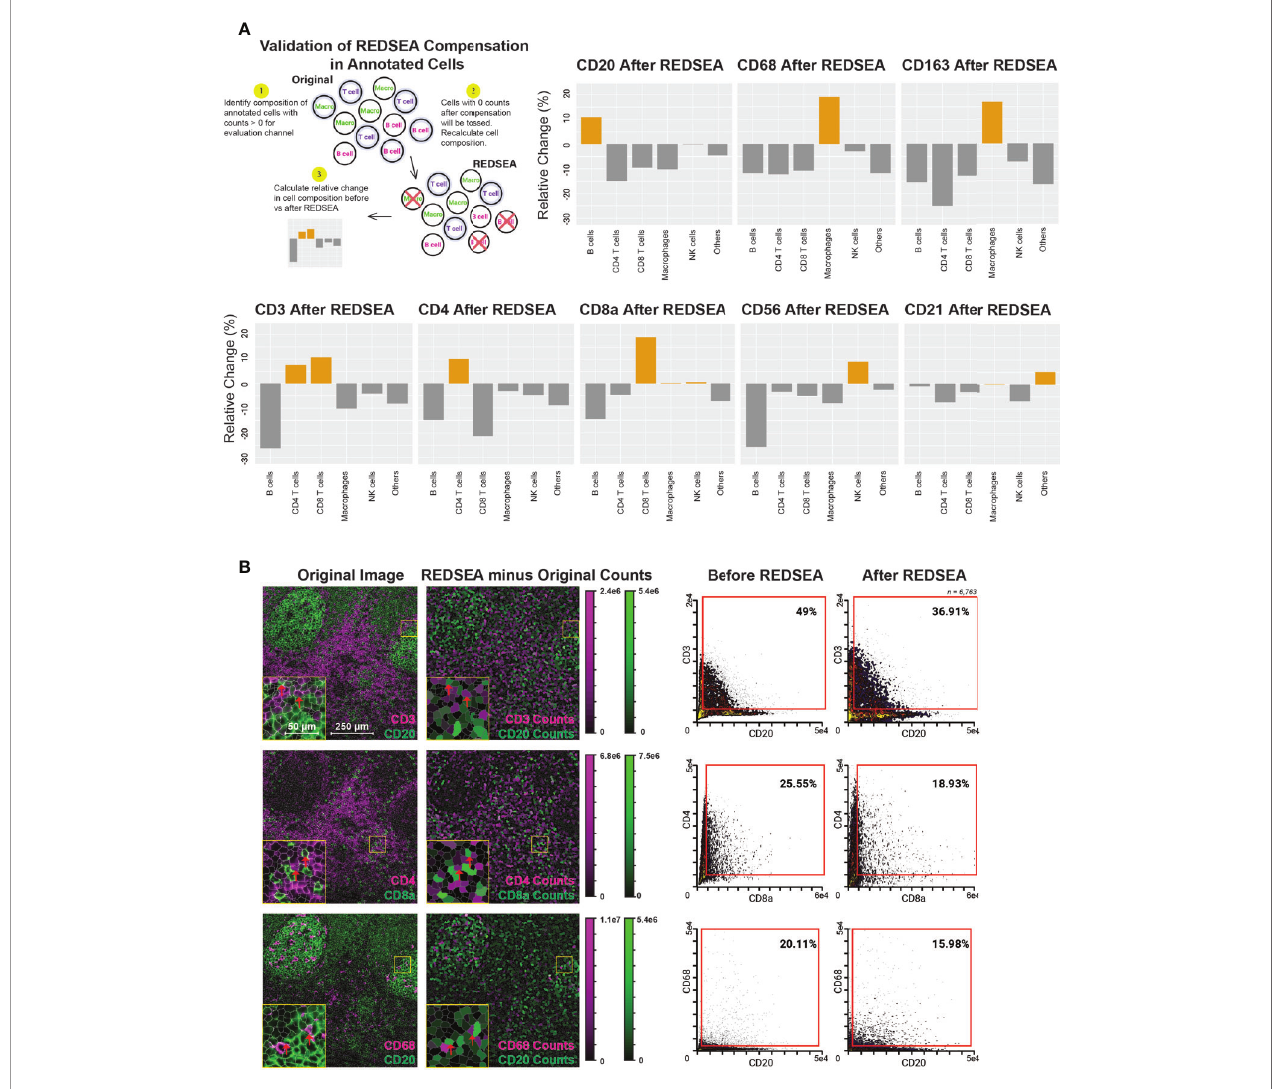
FIGURE 3 | REDSEA Enriches for Cell-type-speci fi c Signals and is Platform Agnostic. (A) Schematic of the work fl ow for calculation of enrichment and depletion of various cell types for each channel before and after REDSEA correction. Cells with no counts in the channel of interest after REDSEA correction were discarded, and the percentage composition of each cell type remaining was calculated. The relative change is the difference in percentage composition of each cell type before and after REDSEA correction. (B) Left: A representative 900 µm x 900 µm CyCIF image of a human tonsil. Three pairs of mutually exclusive markers are shown: CD3 (magenta) and CD20 (green); CD4 (magenta) and CD8a (green); and CD68 (magenta) and CD20 (green). The differences in percentage compositions between the REDSEA image and the original in counts of both markers per segmented cell are shown on a visual scale. Right: Biaxial plots of marker signals from each of the 6,295 single cells extracted from the segmented CyCIF images. The percentage composition of double-positive (top right quadrant) cells is shown for each compensation